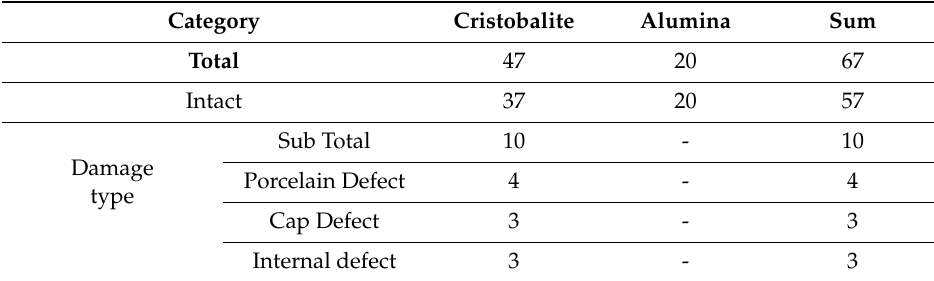
Table 1. Classification of specimens according to material and